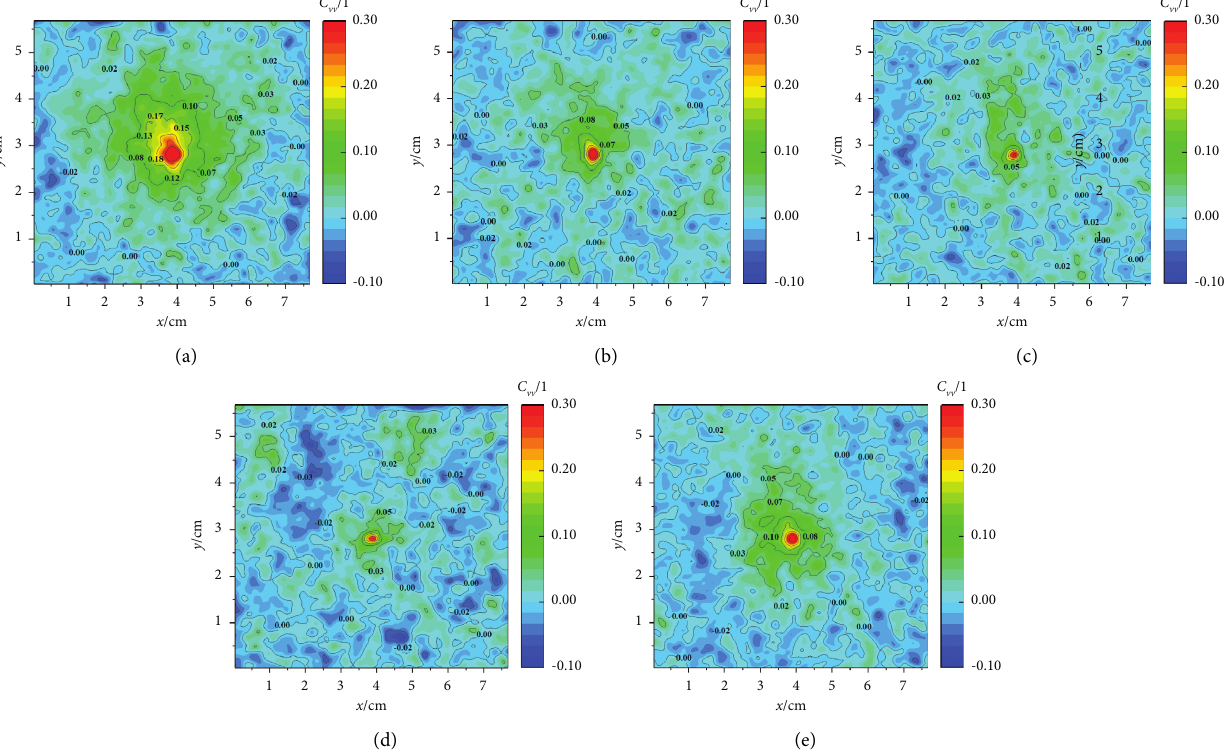
uu in different working conditions. (a) H25-1, (b) H25-1.2, (c) H25-1.5 (D252), (d) D251, and (e) D253. C /1 vv